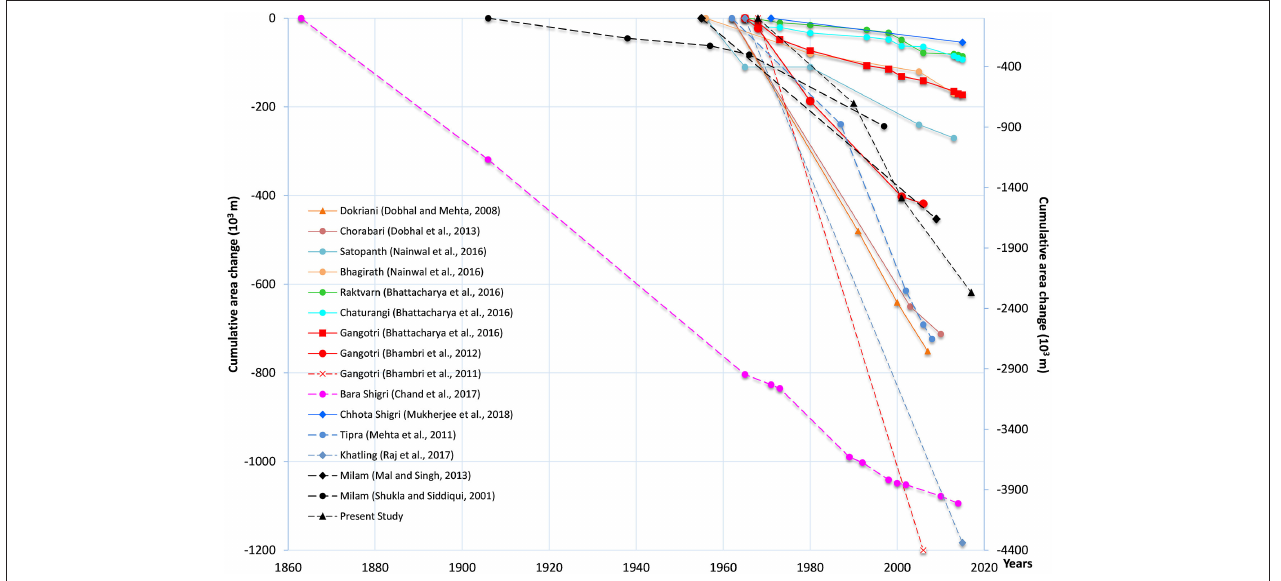
FIGURE 6 | Cumulative area loss of the Milam glacier and some of the Himalayan glaciers. The markers show year of observations. The axis on the right side is for dashed